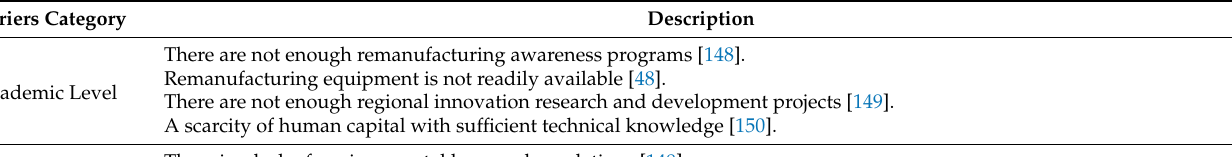
Table 2. Barriers identified by Gunasekara et al.